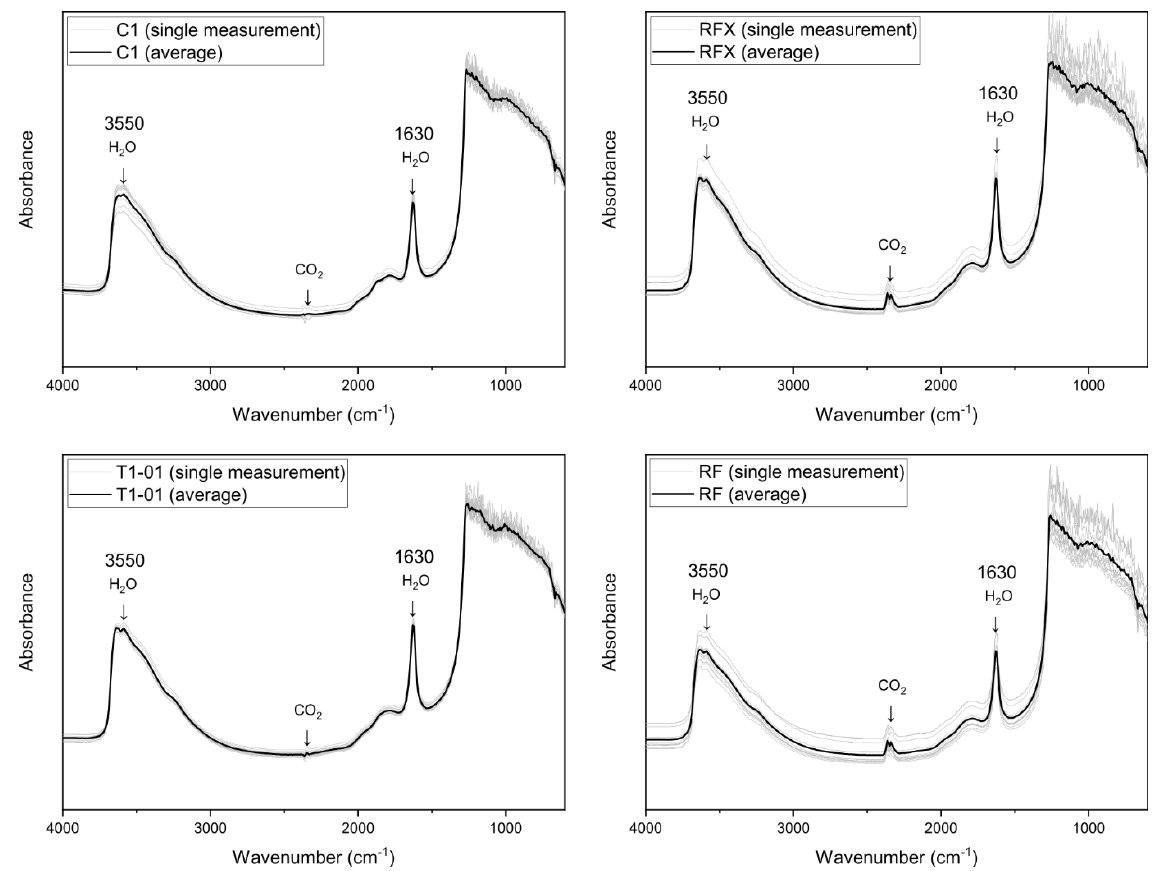
Figure A1. Absorbance spectra of all four analysed samples. Please note that RF and RFX were used only as control measurements and combined under RF in the next figure.